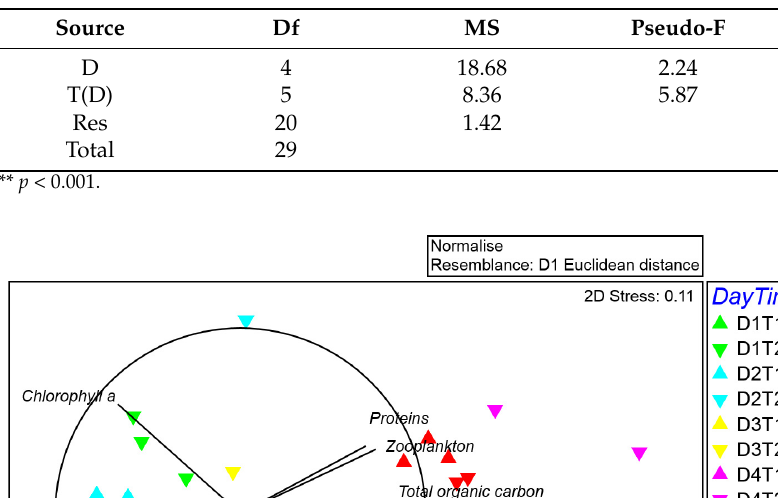
Table 1. Results of multivariate permutational analyses (PERMANOVA) on seston and zooplankton composition across several temporal scales (Day, Time).